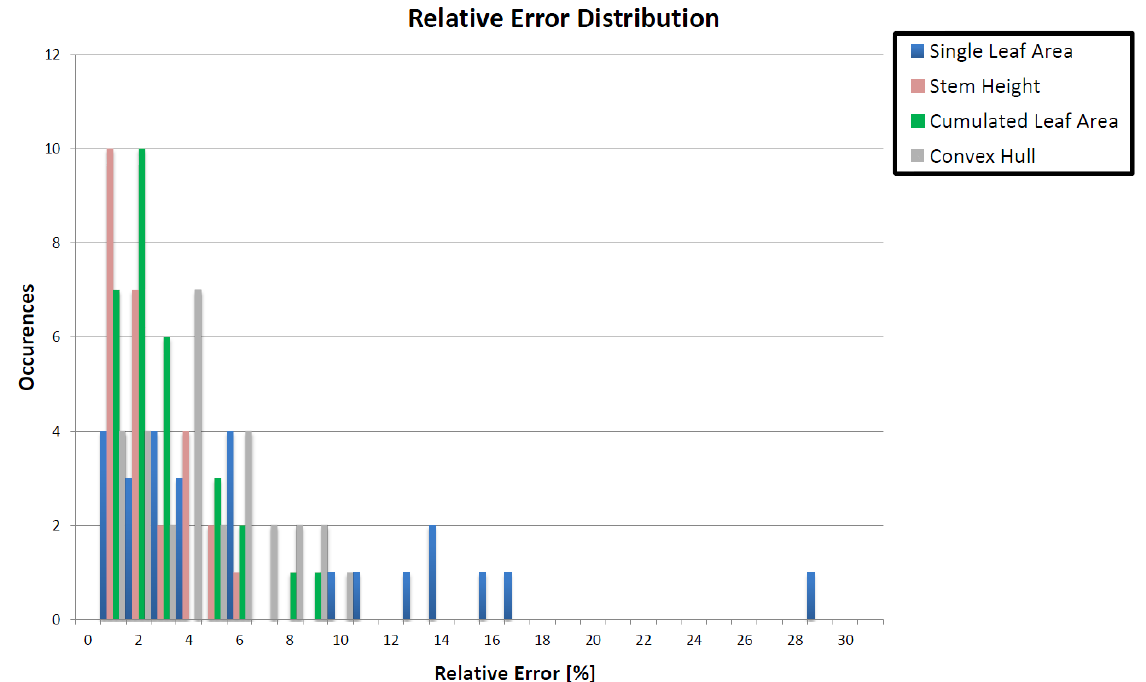
Figure 6. Histogram of the parameters’ relative error